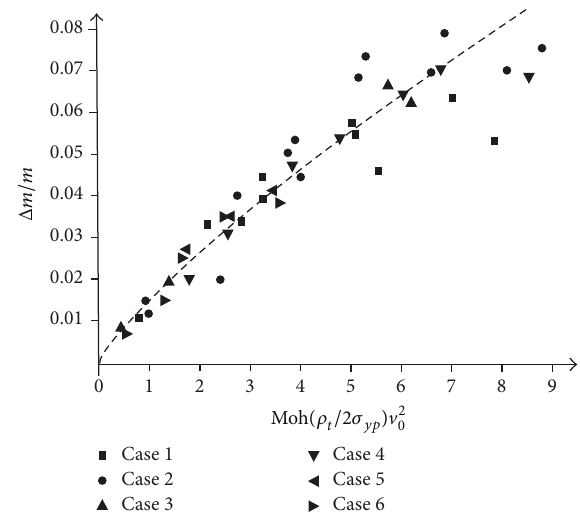
Figure 7: The power relationship between mass erosion and modi- fied dimensionless initial kinetic